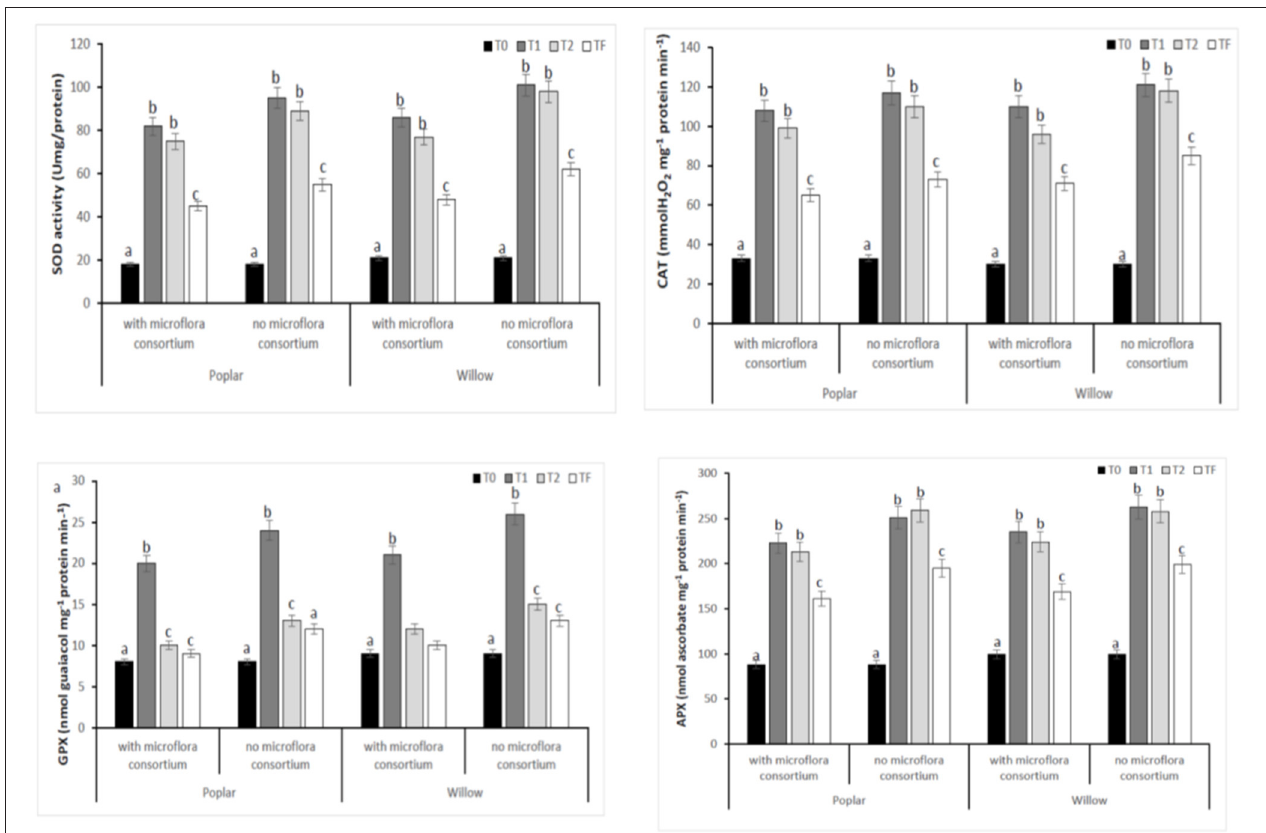
FIGURE 8 | Enzymatic activities of SOD, CAT, GPX, and APX in leaves of hybrid poplar populous deltoids × Populous nigra and willow Salix purpurea subsp. lambertiana at different monitoring time (T 0 :0, T 1 :12, T 2 :24, and T F : 36 months) with microflora consortium and no microflora consortium. Mean values ±